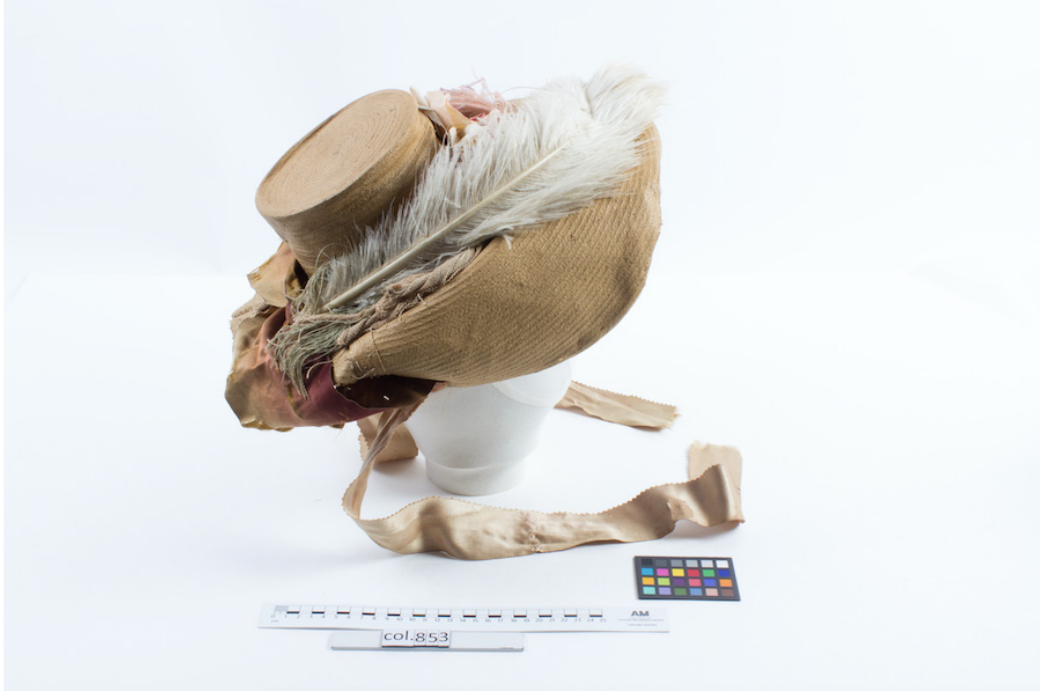
Figure 1. Poke bonnet worn by Mary Ann Williams (Mrs. Preece) in 1828. Courtesy of Wikimedia Commons.